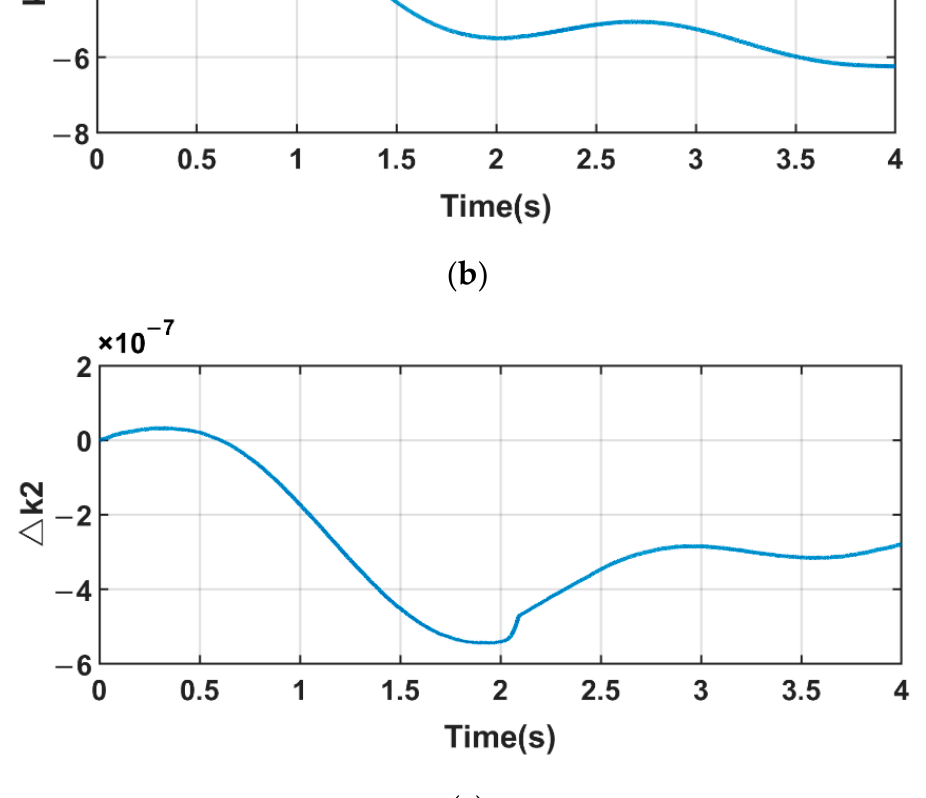
Figure 12. Variation curve of adjustable parameters. ( a ) Variation of k 11 ; ( b ) variation of k 12 ; ( c ) variation of ∆ k 2